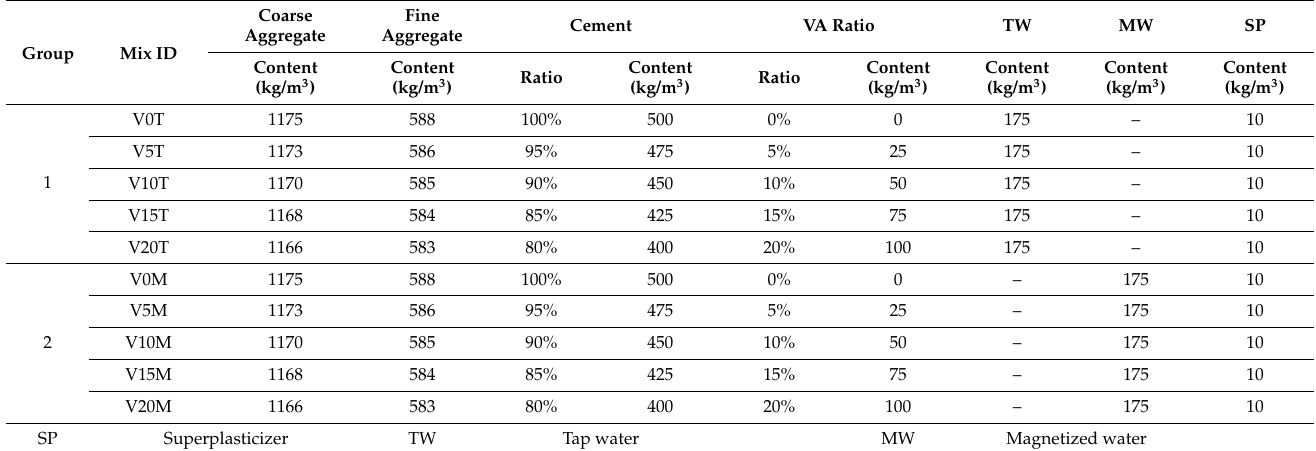
Table 5. Details of mixes used in this study.